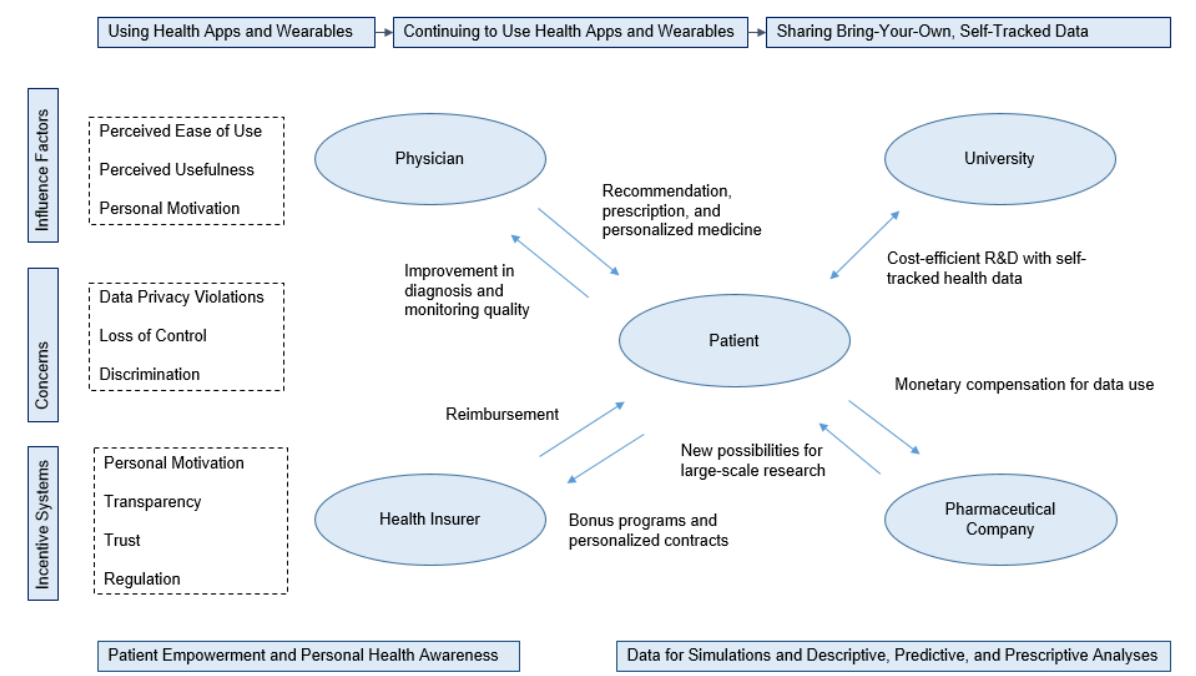
Figure 2. Stages from use to continuous use to the sharing of self-tracked